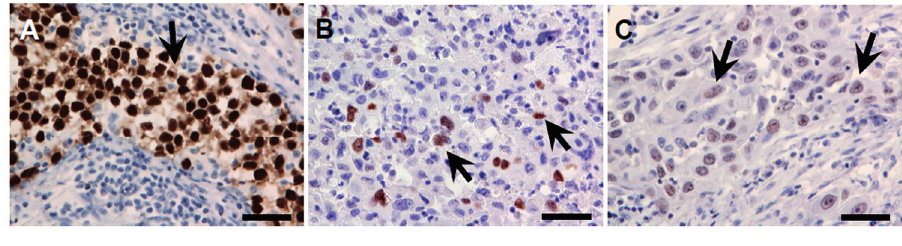
Figure 7. Representative immunostaining with predominant high (( A ), in seminoma tissue), moderate (( B ), in bladder cancer tissue) and low (( C ), in bladder cancer tissue) staining intensity. Arrows show OCT4A-positive nuclei (visualized with DAB (brownish) and counterstained with hematoxylin (blue)); scale bars: 50